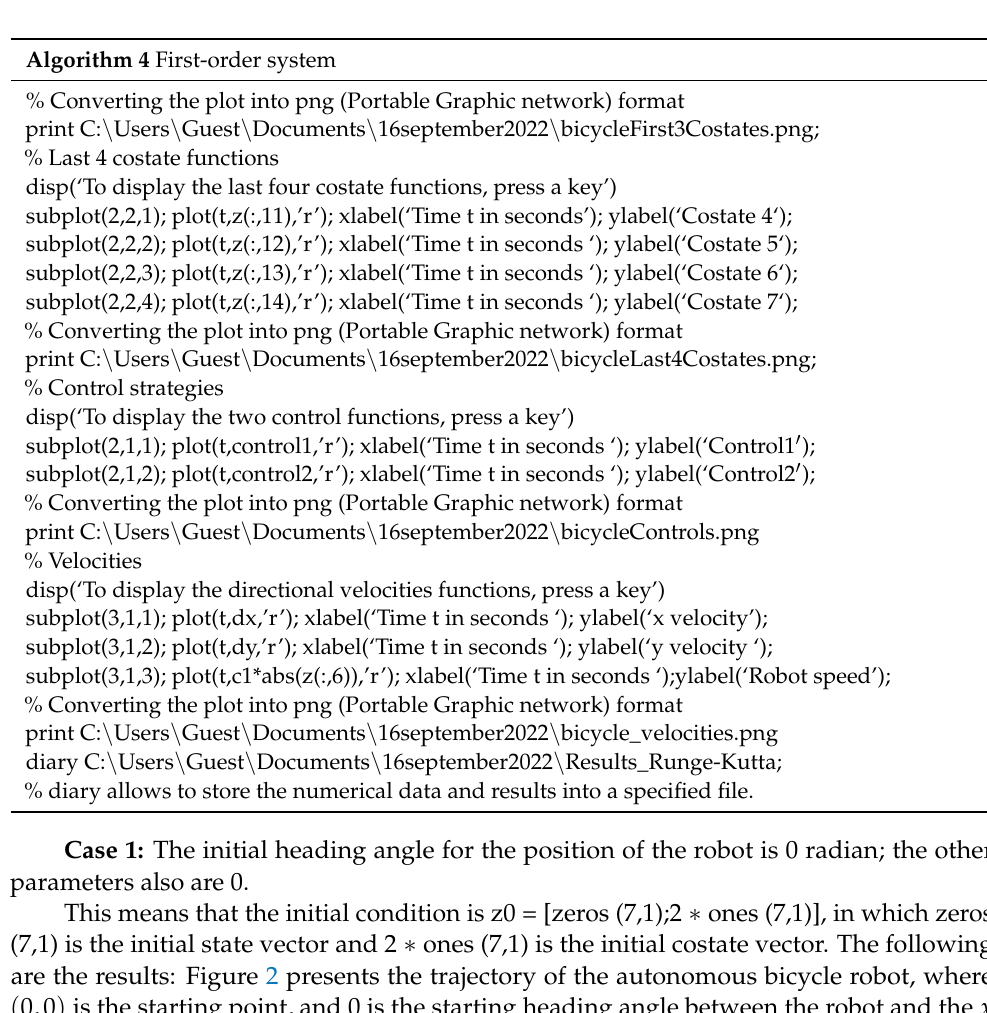
Figure 3. Feasible Vehicle Robot Trajectory (Initial condition = [zeros (7,1);25*ones (7,1)]). Figure 4 presents the first three state functions 𝑥(𝑡) , 𝑦(𝑡) and 𝜃(𝑡) defined, respec- tively, by state 1, state 2 and state 3. The points ( 𝑥(𝑡) , 𝑦(𝑡) ) defines the above feasible trajectory of the robot. In this case, for the starting position of the robot (𝑥(𝑡 = 0) , 𝑦(𝑡 = 0)) = (0,0),𝜃(𝑡 = 0) = 0 , We have the following: